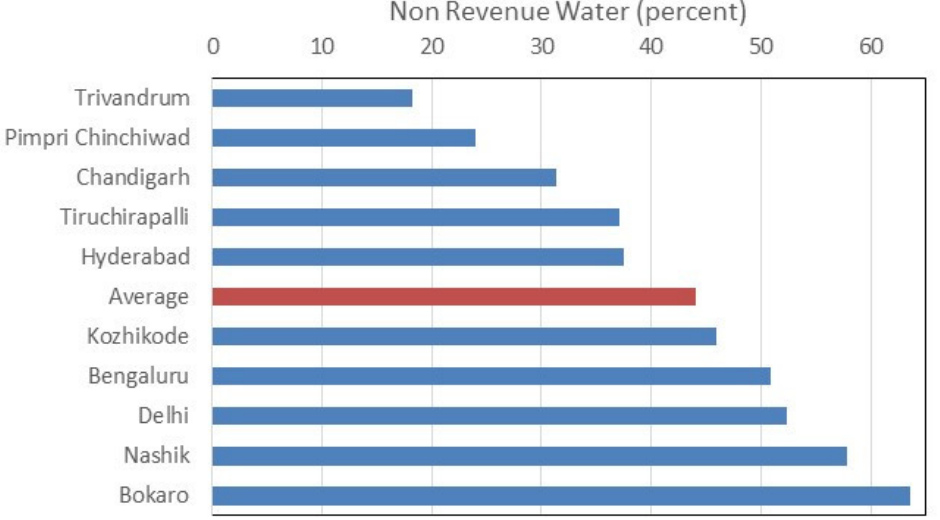
Figure 8. Extent of non-revenue water varies strongly from city to city. The average NRW among Indian urban water utilities surveyed was 44%.